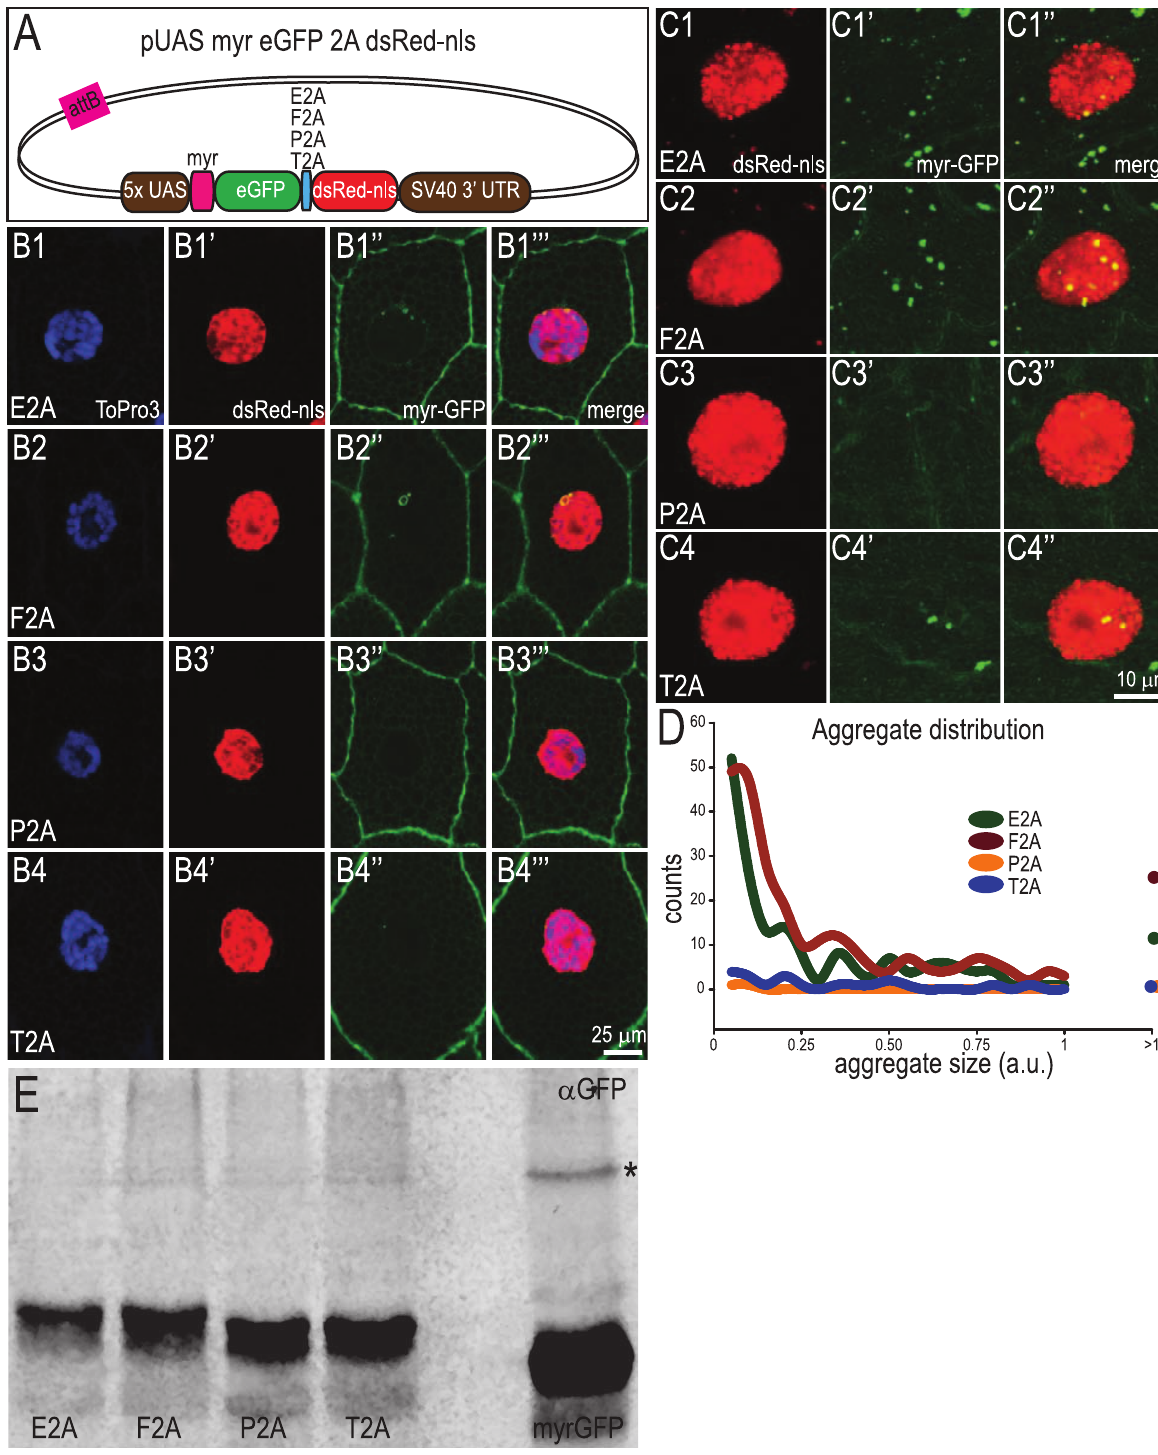
Figure 3. Testing the separation efficiency of 2A peptides invivo . A. Diagram of the DNA construct injected into flies placing expression of myrGFP-2A-dsRed-nls under the control of Gal4. B. Single confocal sections showing separation of myrGFP and dsRed-nls in salivary gland cells from third instar larvae in which UAS-myrGFP-2A-dsRednls is driven by act5c - Gal4 . The first panel for each peptide version shows DNA (stained with ToPro3), the second panel shows dsRed-nls fluorescence, the third shows GFP fluorescence, and the last panel a merged image of all three channels. C. Volume maximum intensity projection of confocal micrographs from larval muscle cells expressing myrGFP-2A-dsRed-nls driven by how 24B– Gal4 . DsRed and GFP fluorescence are shown in the first two panels, respectively, and the third panel shows the merged image. Unseparated protein products appears as aggregates. D. Analysis of dsRed/GFP aggregates in muscle cells. More and larger aggregates are detected in cells expressing E2A- and F2A-linked transgenes, N=2 cells per genotype. E. Western blot from adult fly tissue expressing myrGFP-2A-dsRed-nls driven by tubulin-Gal4 or LexAop-myrGFP driven by act5c-LexA (last lane) as a negative control. The upper band representing unseparated protein product cannot be seen